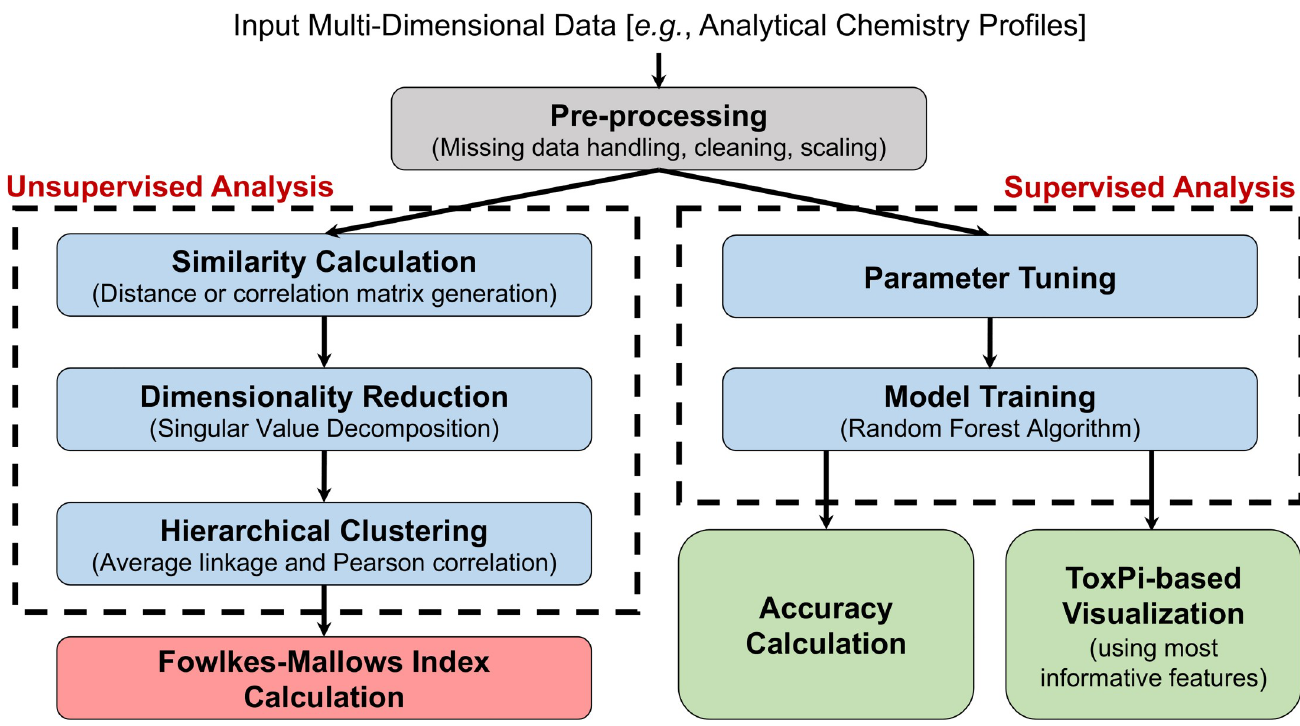
Fig 2. Data processing and visualization